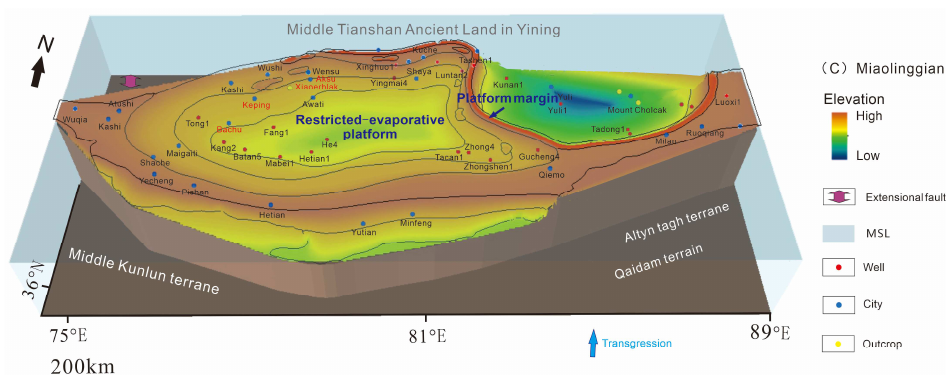
Figure 5. Sedimentary paleogeomorphic characteristics of Cambrian Miaolingian in the Tarim Basin.